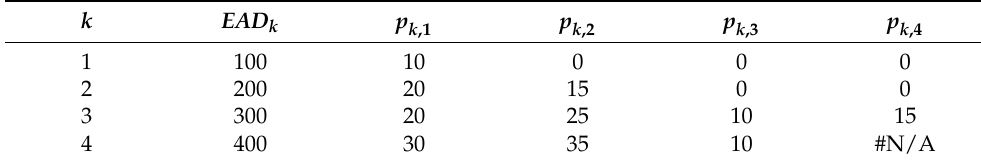
Table 4. Portfolio with K = 4 debt positions and 4 periods of delay.